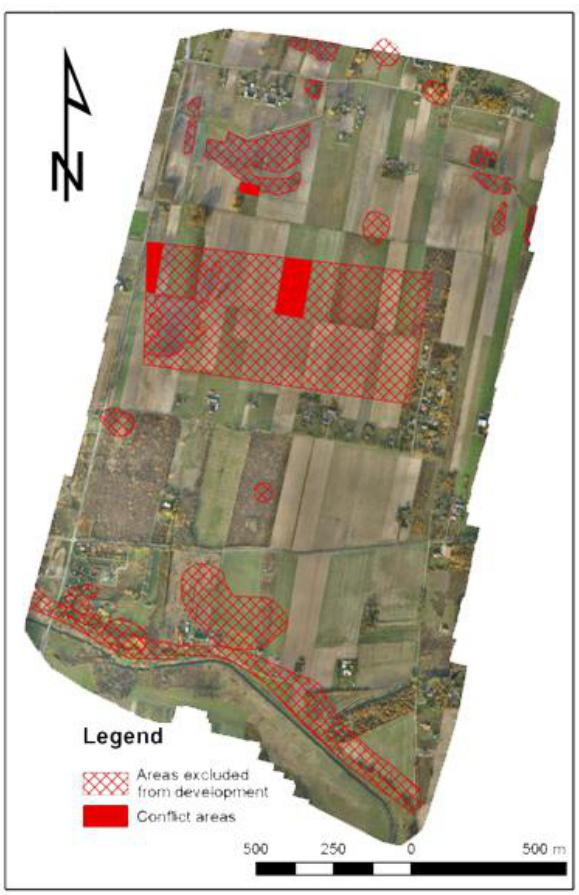
Figure 6. Areas excluded from development, including conflict